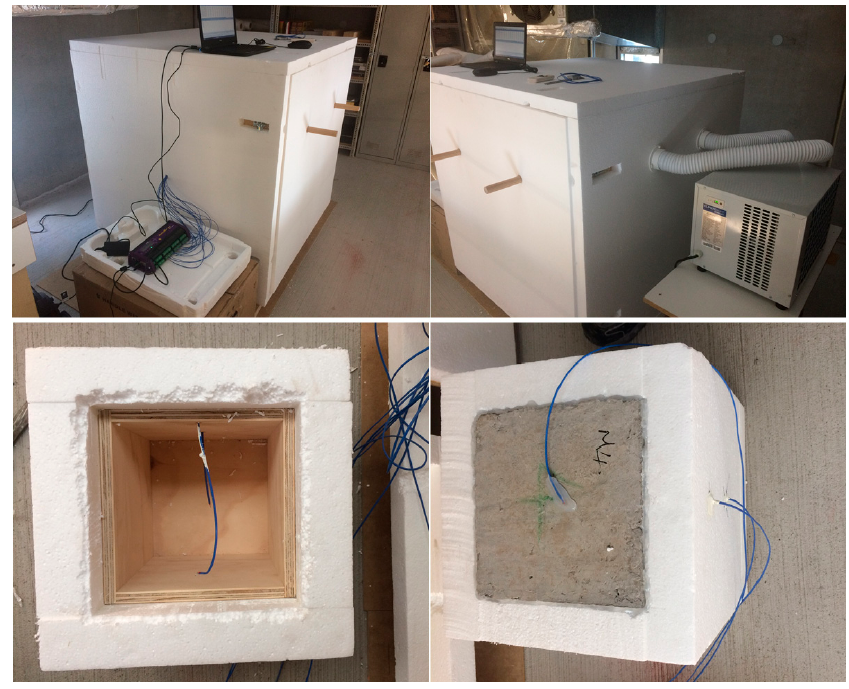
Figure 18. Thermal performance test setup.